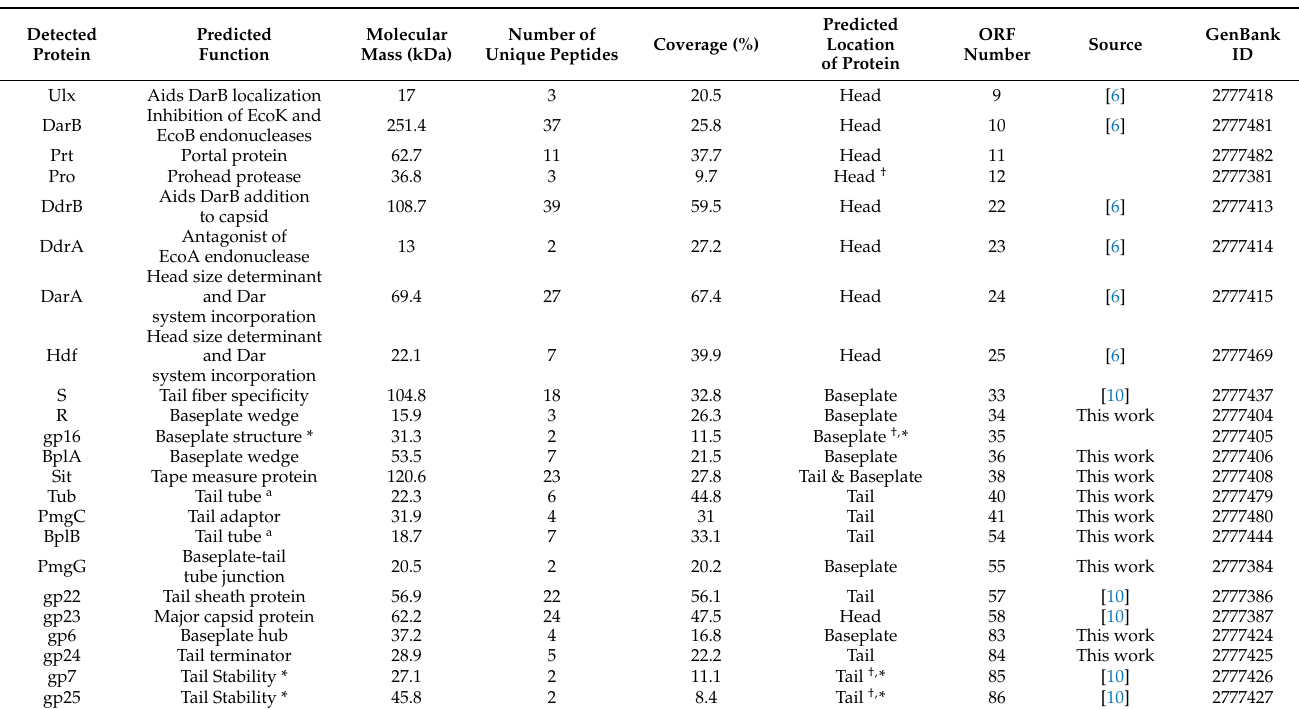
Table 1. Structural proteins identified by LC-MS/MS of purified E. coli phage P1 virions. Predicted functions are assigned based on previous studies or new bioinformatic analyses. Proteins are listed in the order of their open reading frame (ORF) number in the P1